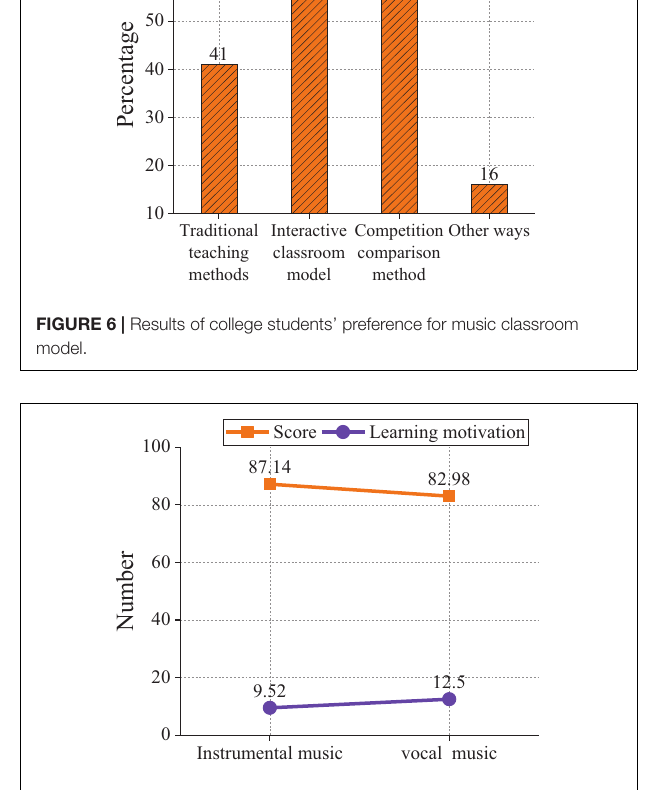
FIGURE 7 | Level of learning motivation of different types of